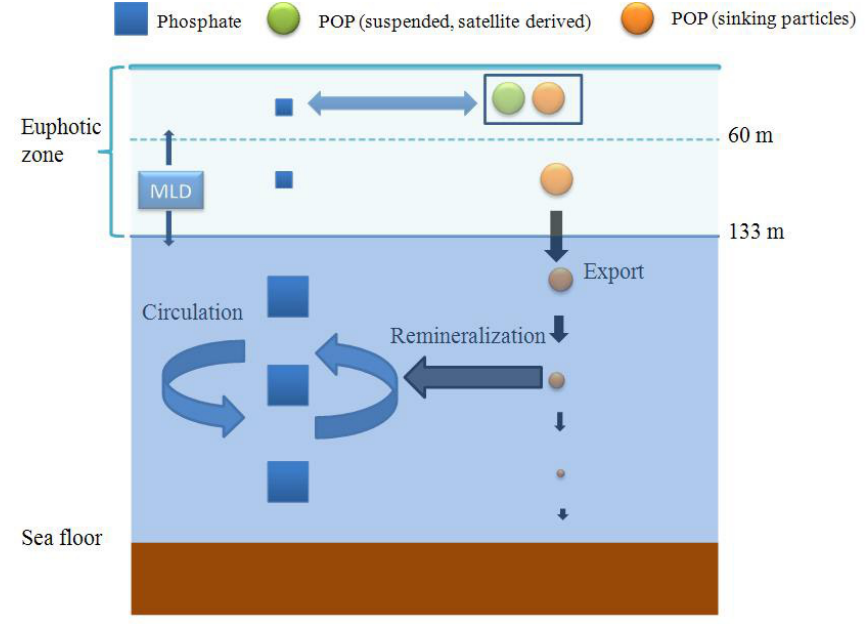
Fig. 4. Schematic diagram of tracers and processes included in model. The two simulated tracers phosphate and particular organic phos- phorous are represented by blue squares and colored dots, with symbol size reflecting typical concentrations. The size of the black arrow indicates decreasing export flux with depth. Phosphate is transported by the ocean circulation (two big blue arrows) and also influenced by the seasonal changes of mixed layer